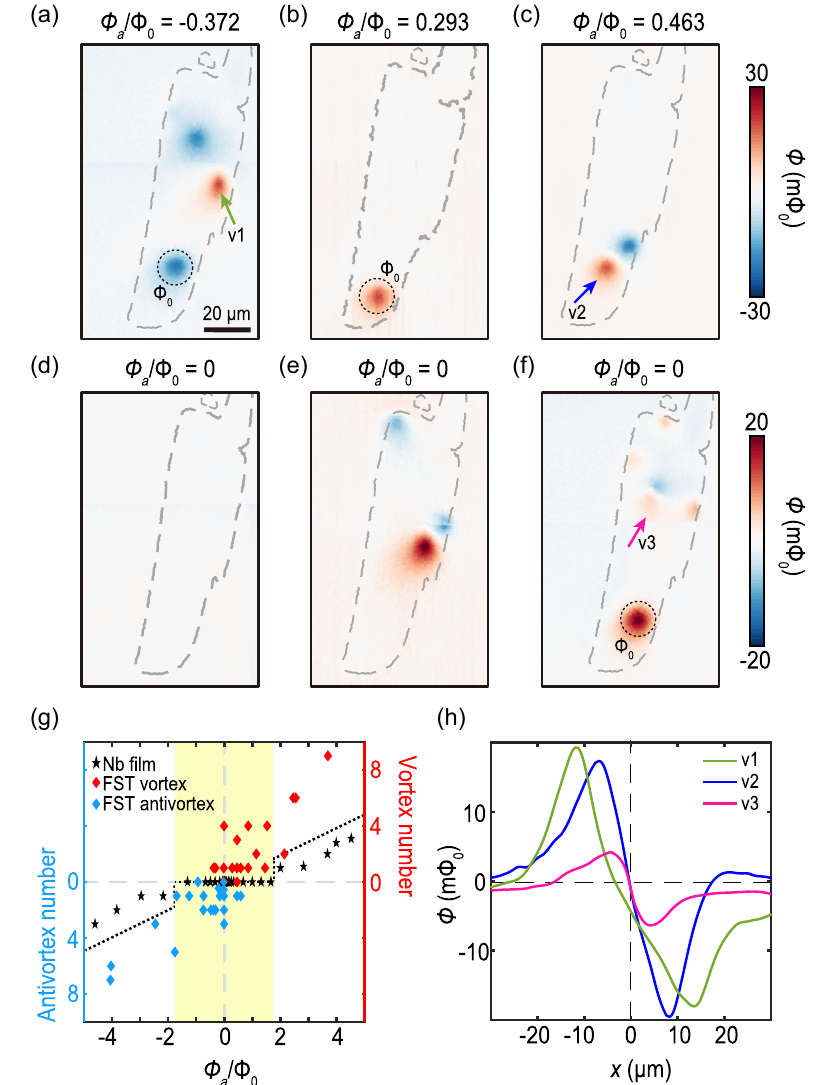
FIG. 2. Spontaneous generation of quantum anomalous vortex in Fe(Se,Te) under zero-field cooling. (a) – (f) Magnetometry images of the sample after field cooling under various j Φ a j < Φ 0 , a regime no vortex was expected to exist on a conventional superconductor. They are representatives of the 27 images obtained in this regime. In the strict zero-field cooling cases (d) – (f), the vortex-antivortex patterns appeared different each time (more in Ref. [38]). Dashed circles in (d), (b), and (f) outline isolated vortices with quantized flux of Φ 0 . (g) Number of vortices as a function of Φ a . The red dots and blue circles represent positive and negative vortex number, respectively, under each cooling case, while the black stars were a baseline from the Nb film [Fig. S5(k) in Supplemental Material [38] ]. The yellow shaded area represents the low-field regime where no vortex was observed on Nb while spontaneous vortices appeared in Fe(Se,Te). The black dashed line outside the low-field regime marks the boundary where the vortex number equals Φ a = Φ 0 . The random and spontaneous vortex formations of both vorticities suggest the nucleation of QAV and antivortex. (h) Line cuts of three typical vortex- antivortex patterns. The three cuts (green, cyan, and magenta) are along the arrow directions v1, v2, and v3 in (a), (c), and (f) with matching colors, respectively. The coupling between QAV-antivortex was stronger when they located